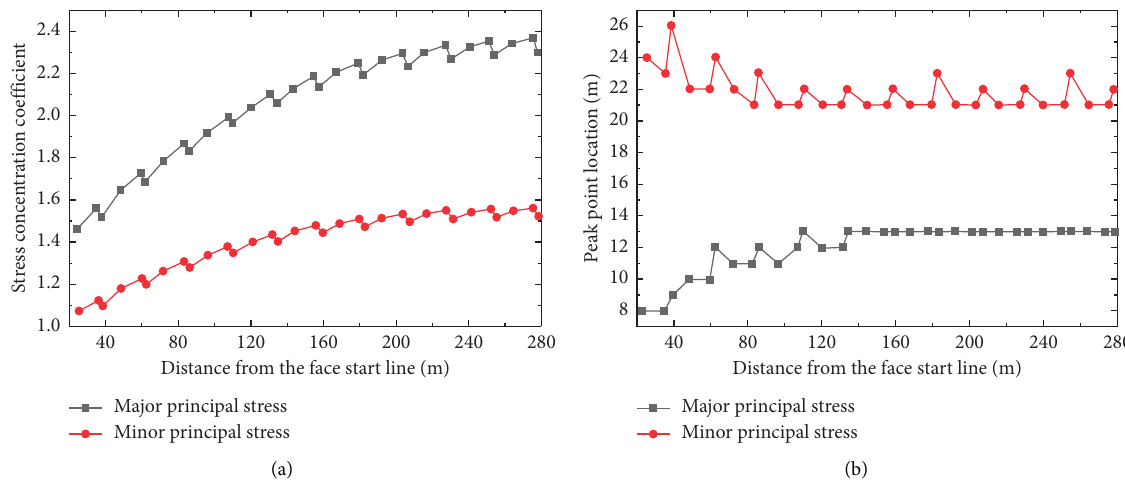
Figure 10: The variation in (a) stress concentration coefficient and (b) peak point location with face